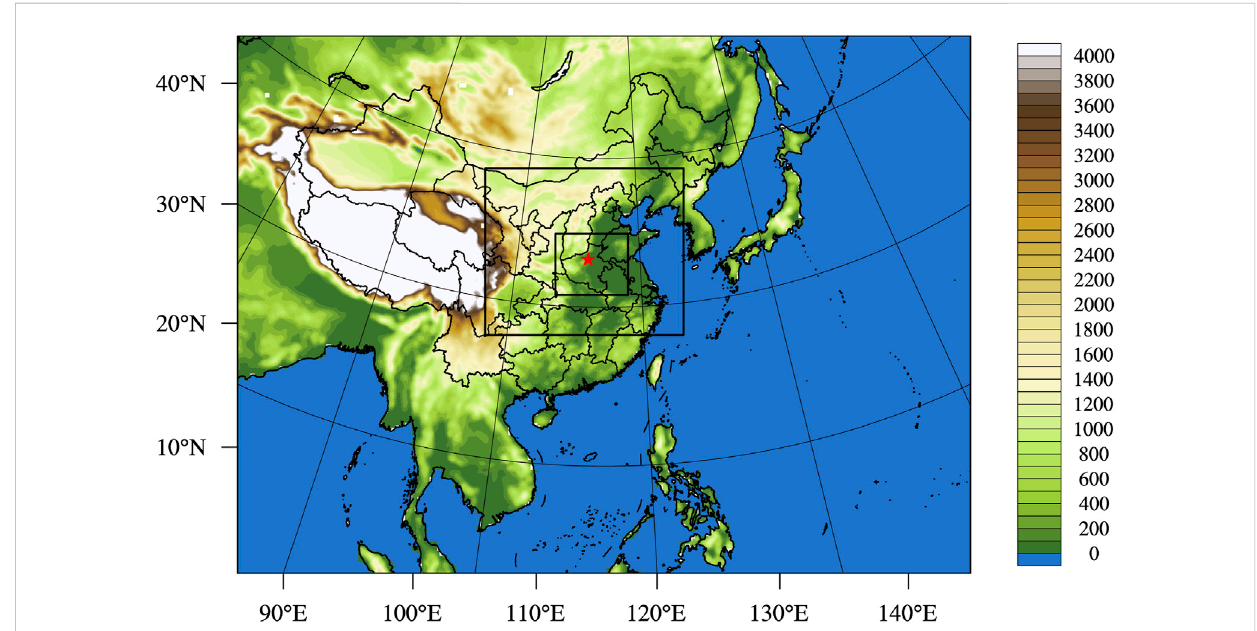
FIGURE 1 Con fi guration of the Weather Research and Forecasting (WRF) model domains (D01-D03); shading represents the terrain height (unit: m). The location of Zhengzhou city is marked as a red pentagram.